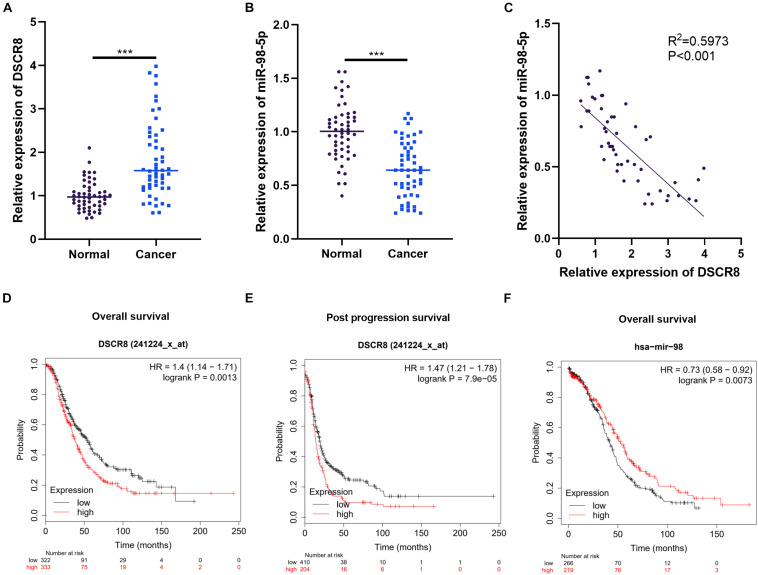
Expression characteristics of DSCR8 and miR-98-5p in ovarian cancer (OC) tissues. (A–C) RT-PCR was used to examine the expressions of DSCR8 and miR-98-5p in 52 OC and adjacent normal tissues. It was revealed that DSCR8 was distinctly upregulated (A), while miR-98-5p was significantly downregulated (B) compared with that of normal adjacent tissues, ***P < 0.001. Linear regression analysis showed that DSCR8 negatively correlates to miR-98-5p expression (C). (D–F) The diagnostic significance of DSCR8 and miR-98-5p expression levels on prognosis was analyzed through KM plotter (http://kmplot.com/analysis/index.php?p=service). DSCR8 was significantly associated with overall survival (D) and post progression survival (E) in patients with cervical cancer. MiR-98-5p is strongly associated with overall survival (F) in OC patients.